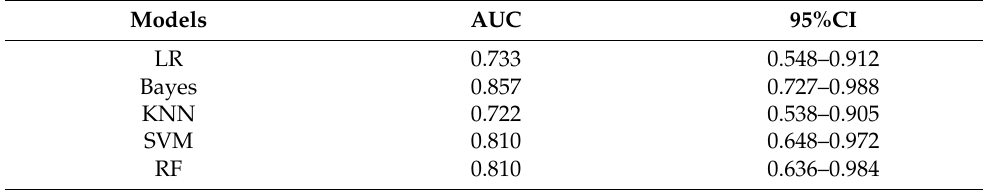
Table 4. Comparison of radiomics model performance in the external validation group. Models